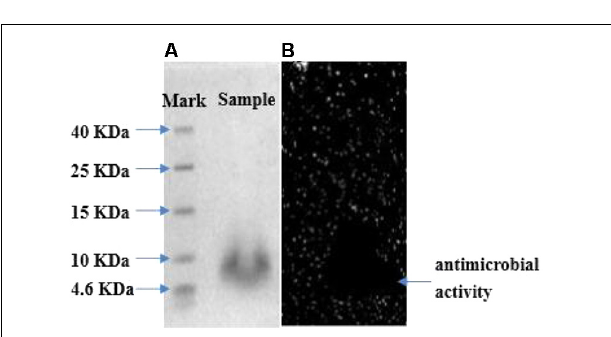
FIGURE 5 | (A) Tricine SDS–PAGE analysis of purified bacteriocin Lac-B23; (B) gel